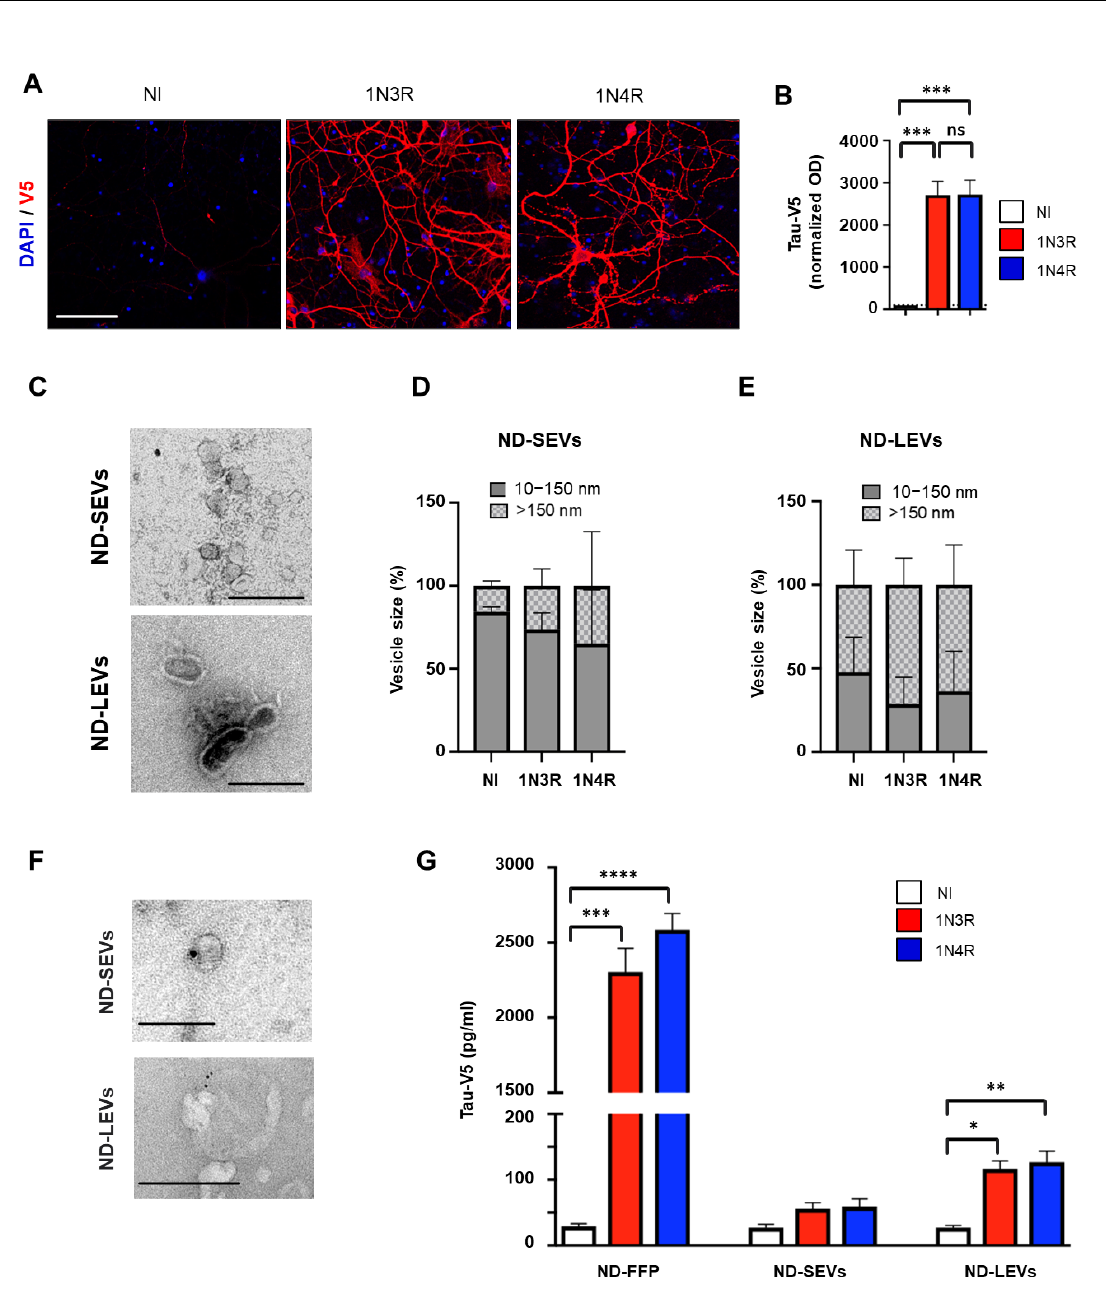
Figure 2. Neuronal tau is mainly secreted in a free form. ( A ) Confocal micrographs showing tau (V5+) in rat hippocampal neurons infected by LVs overexpressing 1N3R or 1N4R tau; NI = noninfected. ( B ) Histogram showing Tau-V5 accumulation (optical density normalized to that in the NI condition) in rat hippocampal neurons overexpressing 1N3R or 1N4R tau. ( C ) Electron microscopy images of ND-SEVs and ND-LEVs isolated from cultured neurons. The scale bar is 250 nm. ( D ) Histogram showing the percentage of ND-SEVs with a size between 100–150 nm and greater than 150 nm. ( E ) Histogram showing the percentage of ND-LEVs with a size between 100–150 nm and greater than 150 nm. ( F ) Electron microscopy and immunogold labeling (Cter-tau) of ND-SEVs and ND-LEVs isolated from the supernatant of neurons overexpressing 1N4R tau. The scale bar is 100 nm for ND-SEVs and 250 nm for ND-LEVs. ( G ) Histogram showing Tau-V5 concentration in the ND-FFP, ND-SEV, and ND-LEV fractions from control rat hippocampal neurons (NI) and those overexpressing 1N3R or 1N4R tau. For ( B , G ), n = 4 cultures per condition; ordinary one-way ANOVA with Sidak’s multiple comparison test and the nonparametric Kruskal–Wallis test, in ( B ) and ( G ), respectively. ( ns p > 0.05, * p < 0.05, ** p < 0.01, *** p < 0.001, **** p <